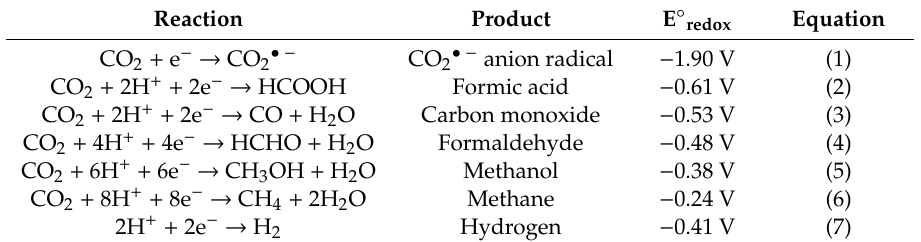
Table 1. The main products of CO 2 reduction with the corresponding reduction potentials (pH = 7).